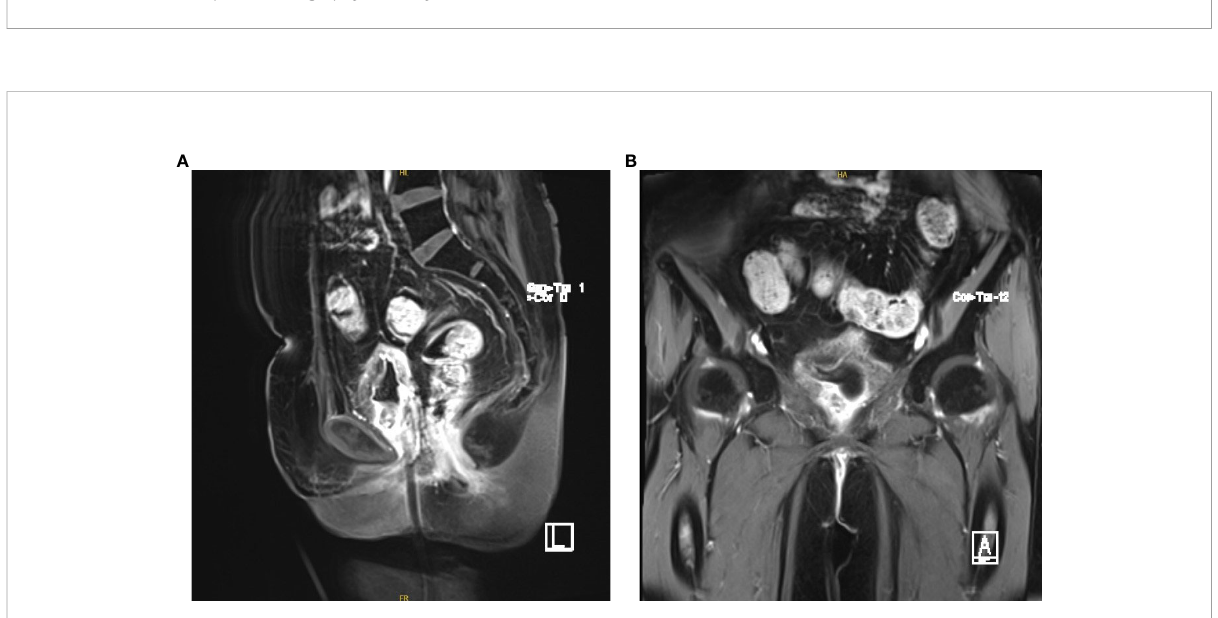
FIGURE 7 (A, B) Pelvic magnetic resonance imaging (May 17,